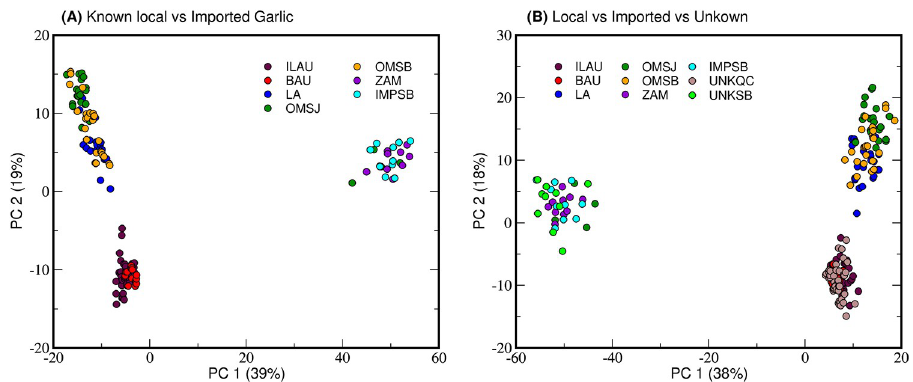
Fig 5. Scores plot (log, centered) comparing local and imported samples. Sugars and dipeptides, which influence clustering, are distributed in both local and imported samples.